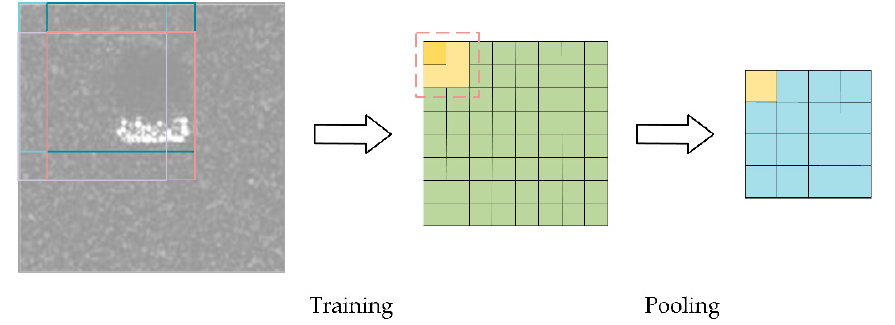
Figure 6. Feature evolution.